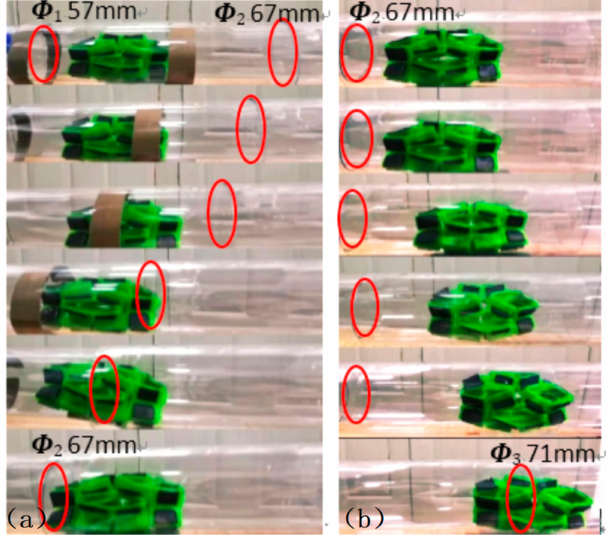
Figure 11. The origami flexiball robot crawls through variable diameter pipes (the nested connections of variable diameter pipes are marked using red circles): ( a ) from ∅ 57 mm pipe to ∅ 67 mm pipe; ( b ) from ∅ 67 mm pipe to ∅ 71 mm